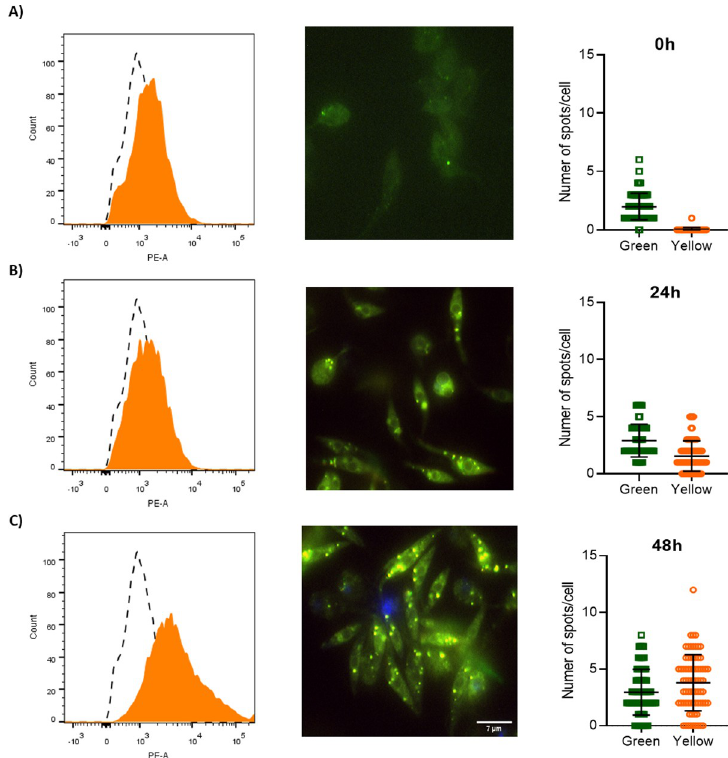
Fig 6. Epimastigote forms accumulates fatty acids into lipid droplets during growth. The epimastigotes were treated with 1 μ M BODIPY C 1 -C 12 (500/510) and analysed by flow cytometry and fluorescence microscopy. A) 0 h. B) 24 h. C) 48 h. In the flow cytometry histograms, dashed peaks represent unstained parasites. Yellow filled peaks represent positively stained parasites. The number of green/yellow spots for each cell was calculated using ImageJ software. All the experiments were performed in